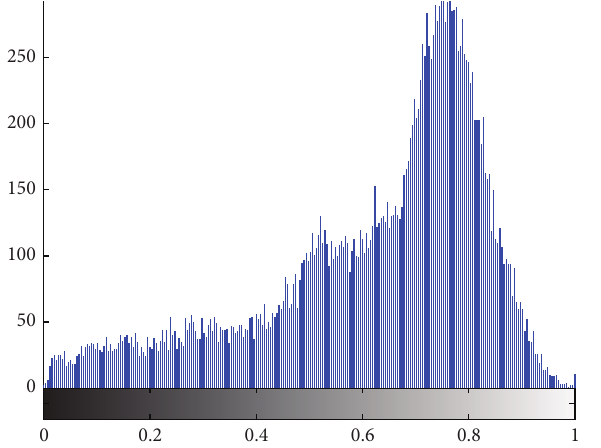
Figure 4: Grayscale histogram of tongue.